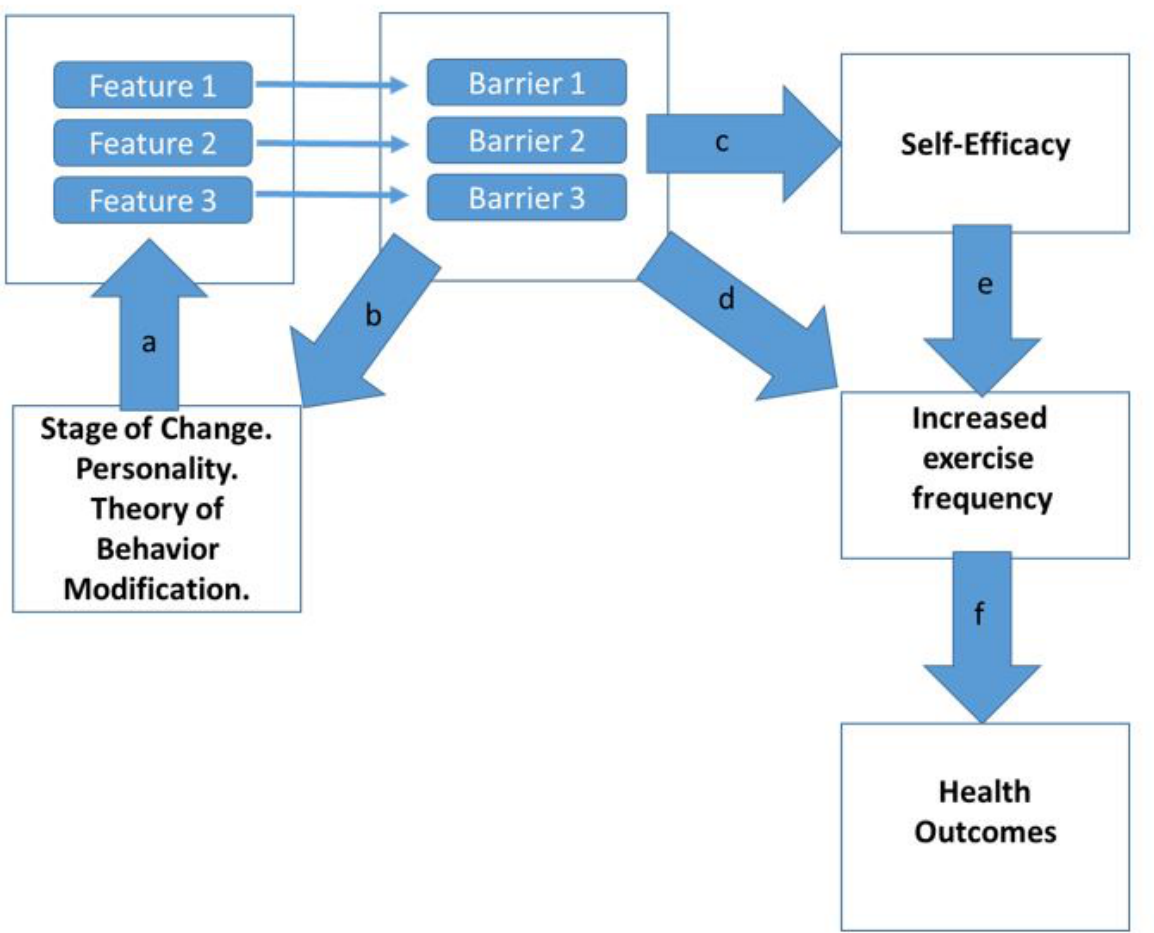
Figure 5. Barrier-centered model of exercise apps as exercise behavior-change intervention delivery systems. In this model, an individual’s barriers are taken into account during the app design process (b) personality, stages of change, and theory-driven approaches are all used in tailoring sets of features (a) that will maximally help the individual overcome their barriers. The effectiveness of the features leads to increased exercise frequency either directly (d) or through increased self-efficacy (c, e), leading to improved health outcomes